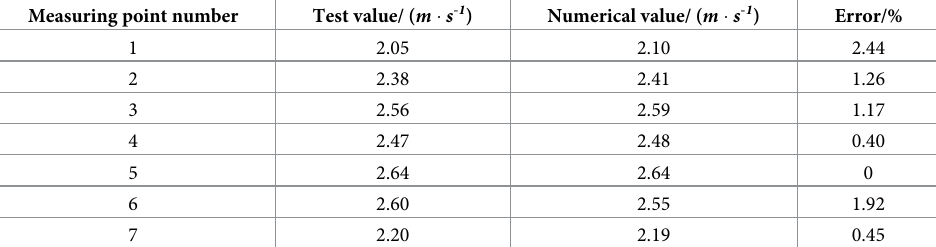
Table 1. Comparison of simulated and experimental